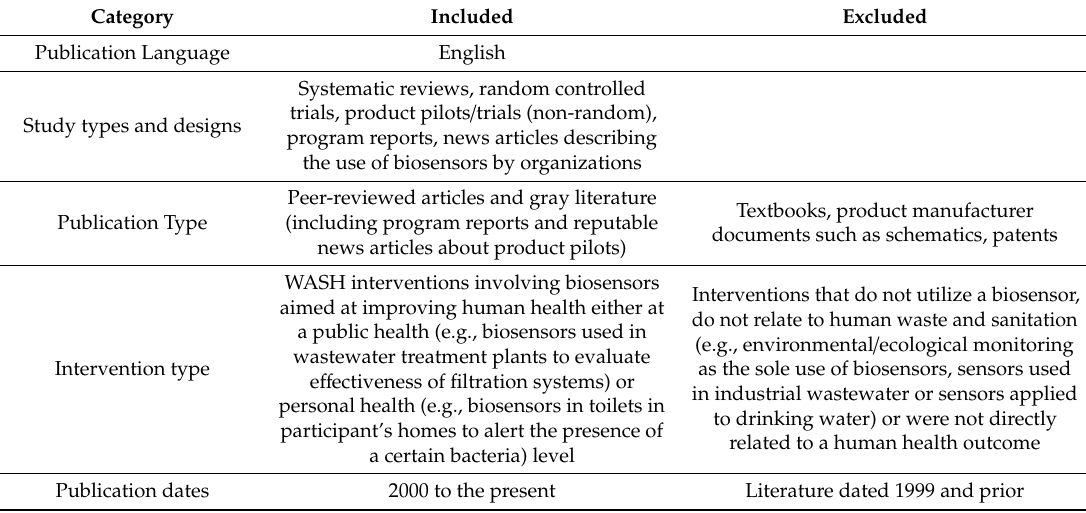
Table 1. Inclusion and Exclusion